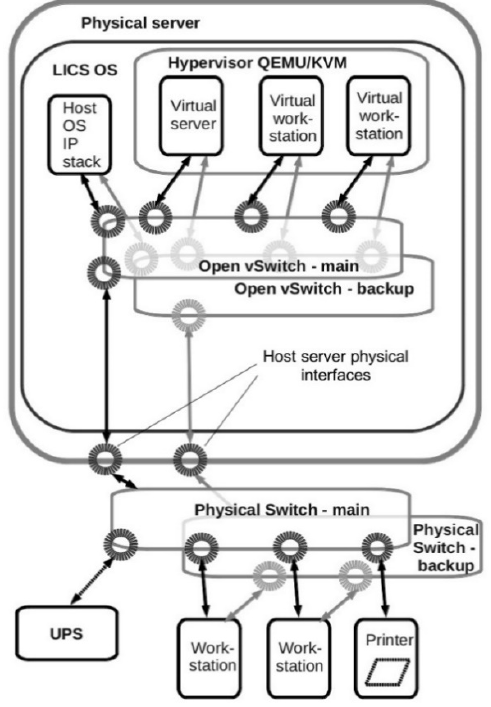
Figure 5. The outline of the heterogeneous digital model of the ULCS. with an operator terminal, server cabinet.